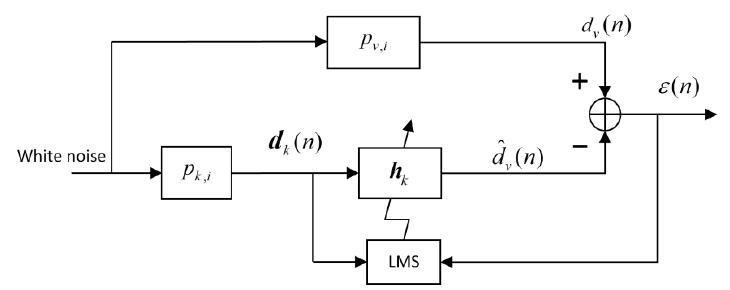
Figure 4. Block diagram of the adaptive least mean square (LMS) algorithm to calculate microphone weights.